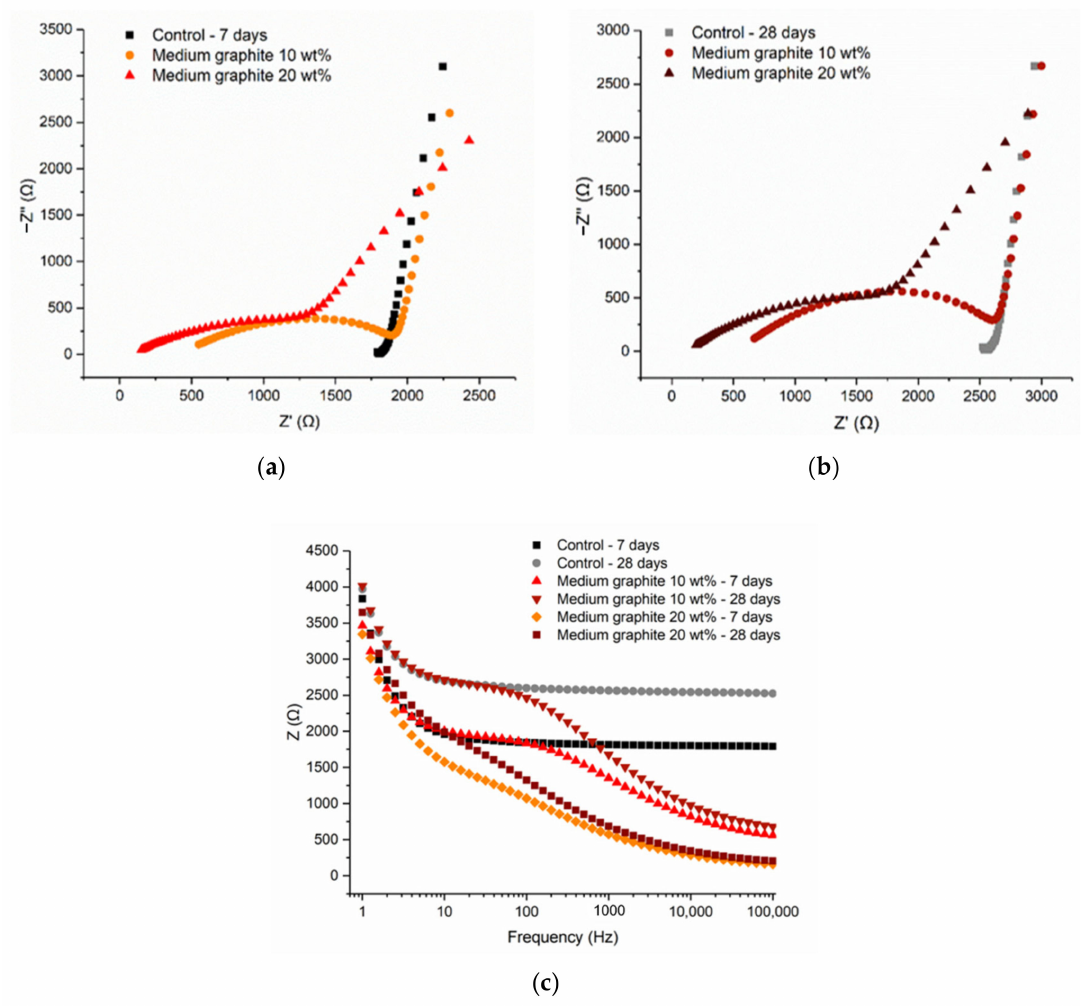
Figure 12. Cement paste with medium graphite: ( a ) 7-day Nyquist plot, ( b ) 28-day Nyquist plot, and ( c ) frequency-dependent